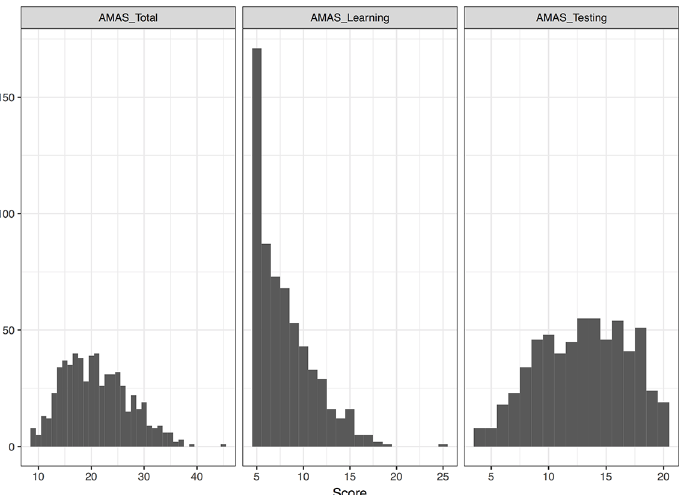
Figure 1. Distributions of AMAS online. Total score (Panel A; theoretical range from 9 to 45), AMAS Learning scale (Panel B; theoretical range from 5 to 25) and AMAS Testing scale (Panel C; theoretical range from 4 to